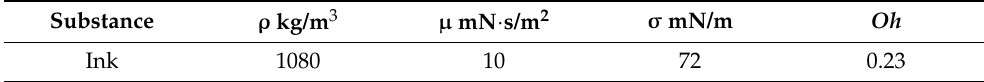
Table 1. Inkjet inks parameters.